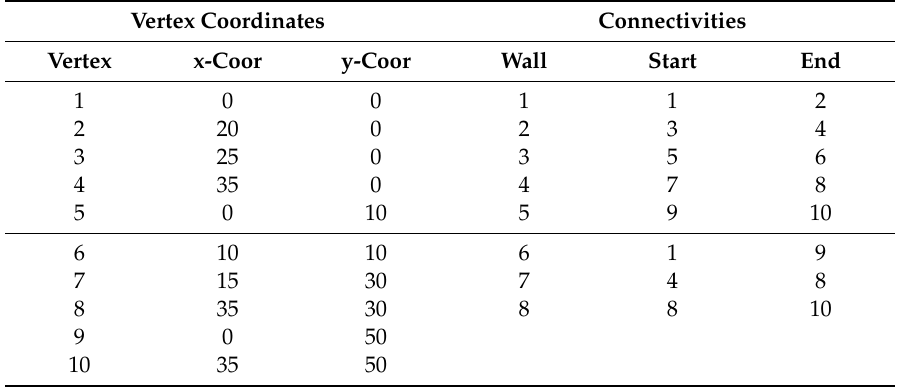
Figure 9. Example 2: eight-wall flat. The first R and D solutions are with T = 35. Table 4. Joint coordinates and wall start / end points. Example 2 with eight